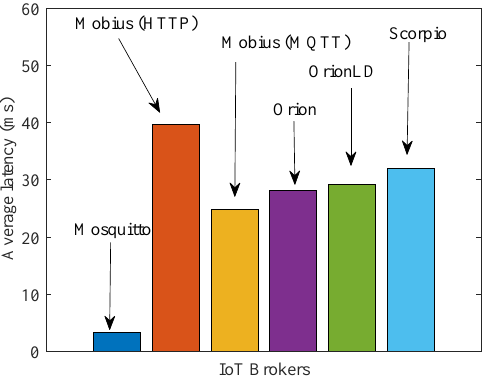
Figure 18. Average latency of native systems (to be compared with Figure